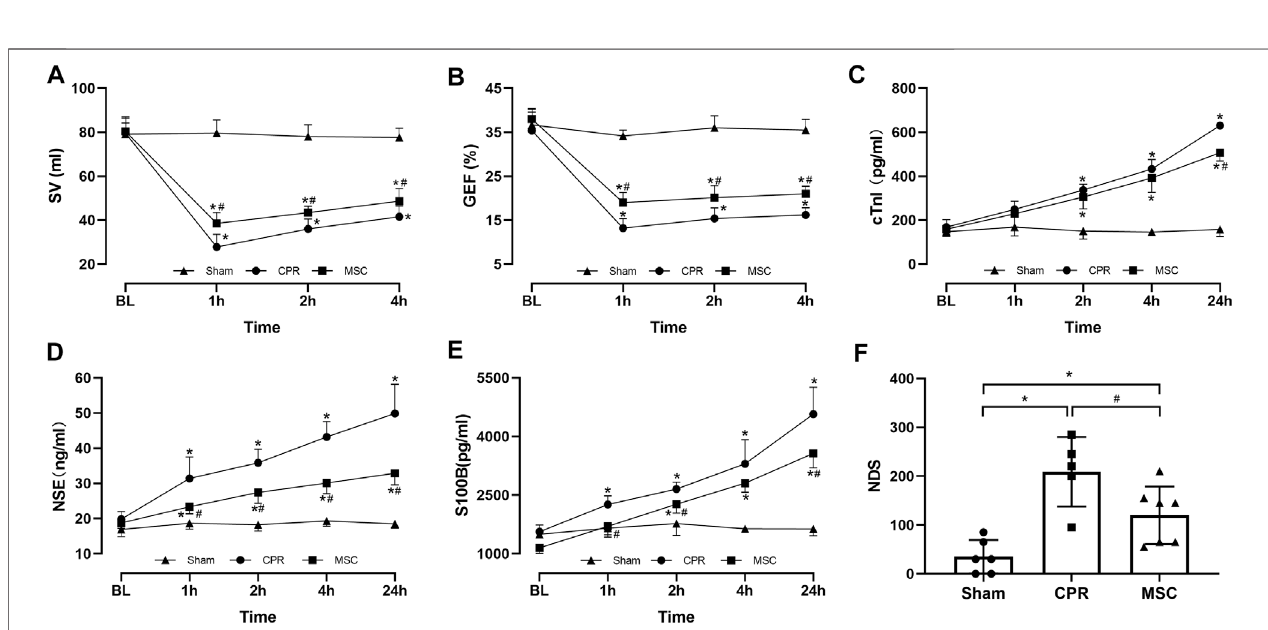
FIGURE2| Hemodynamics,bloodgasandlactate (A) Heartrate(HR) (B) Meanarterialpressure(MAP) (C) pH (D) PaO 2 ( E )PaCO 2 (F) Lactate.BL,baseline;CPR, cardiopulmonary resuscitation; MSC, mesenchymal stem cell. * p < 0.05 versus sham group; # p < 0.05 versus CPR group.